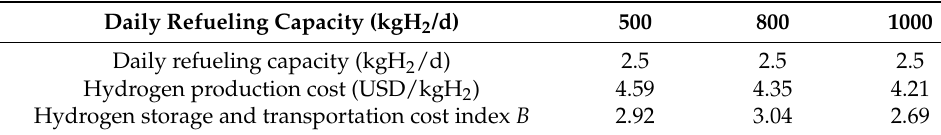
Table 4. The summary of results about hydrogen-related